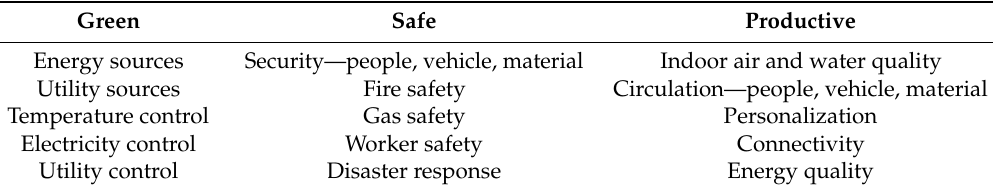
Table 2. The Honeywell Smart Building Score TM 2.0 components (adapted from reference [27]).